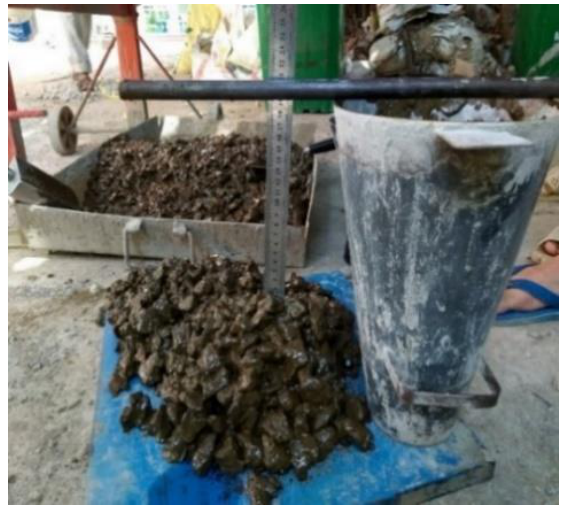
Figure 7. Slump measurement of fresh concrete.